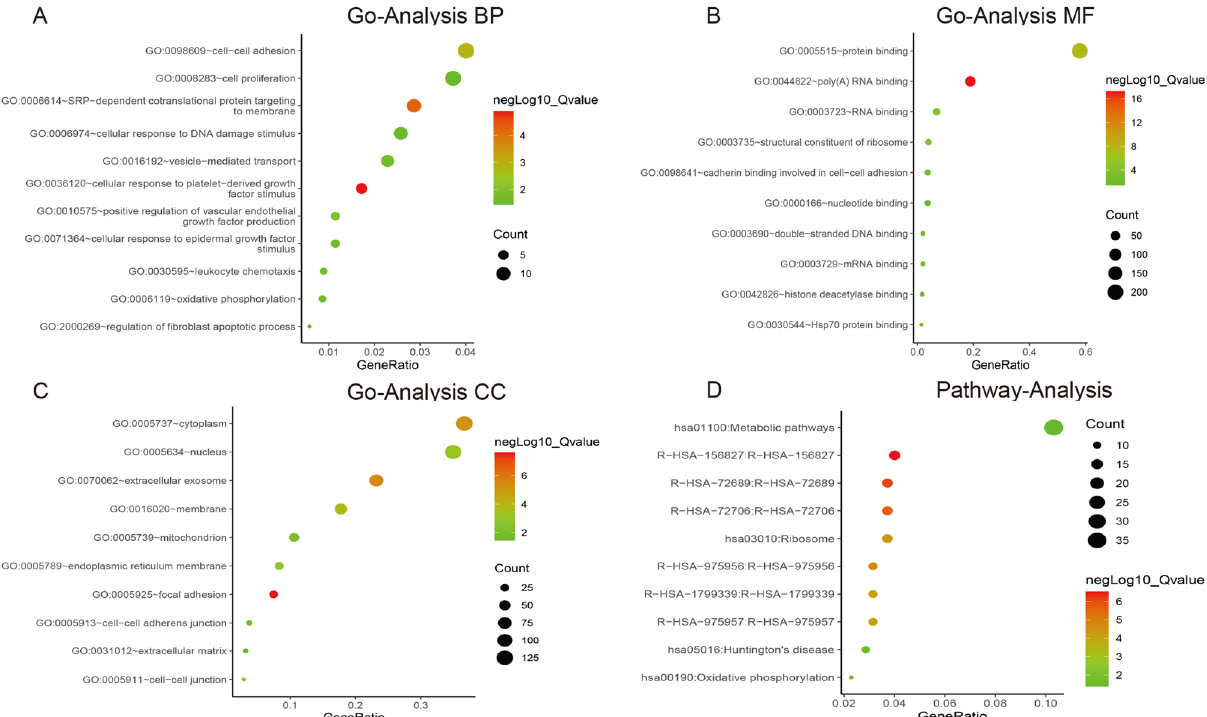
DEGs respectively. Differentially expressed genes, DEGs, Gene ontology, GO. Created with DAVID version 6.8 (https:// david. ncifc rf. gov/, accessed November, 2019) and R soft 3.5.3 (https:// mirro rs. tuna. tsing hua. edu. cn/